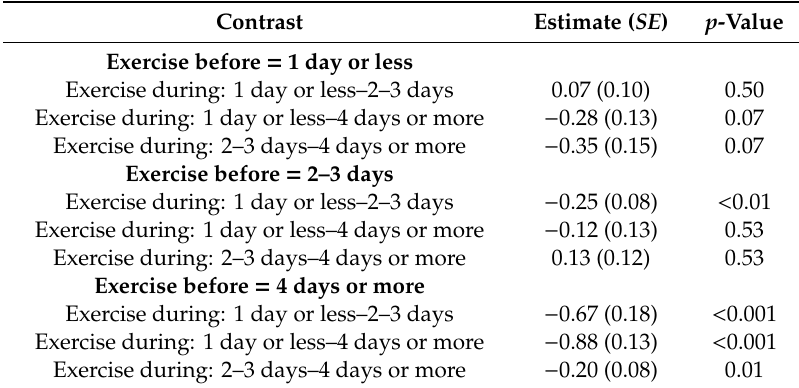
Table 5. Post-hoc contrasts comparing mood states with the pairwise test for di ff erent exercise frequency groups pre and during the pandemic. Contrast Estimate ( SE ) p -Value Exercise before = 1 day or